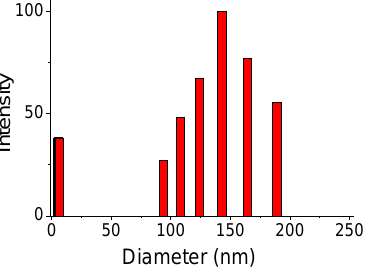
Figure 2. Distribution of hydrodynamic radii ( R 10 mg/mL).